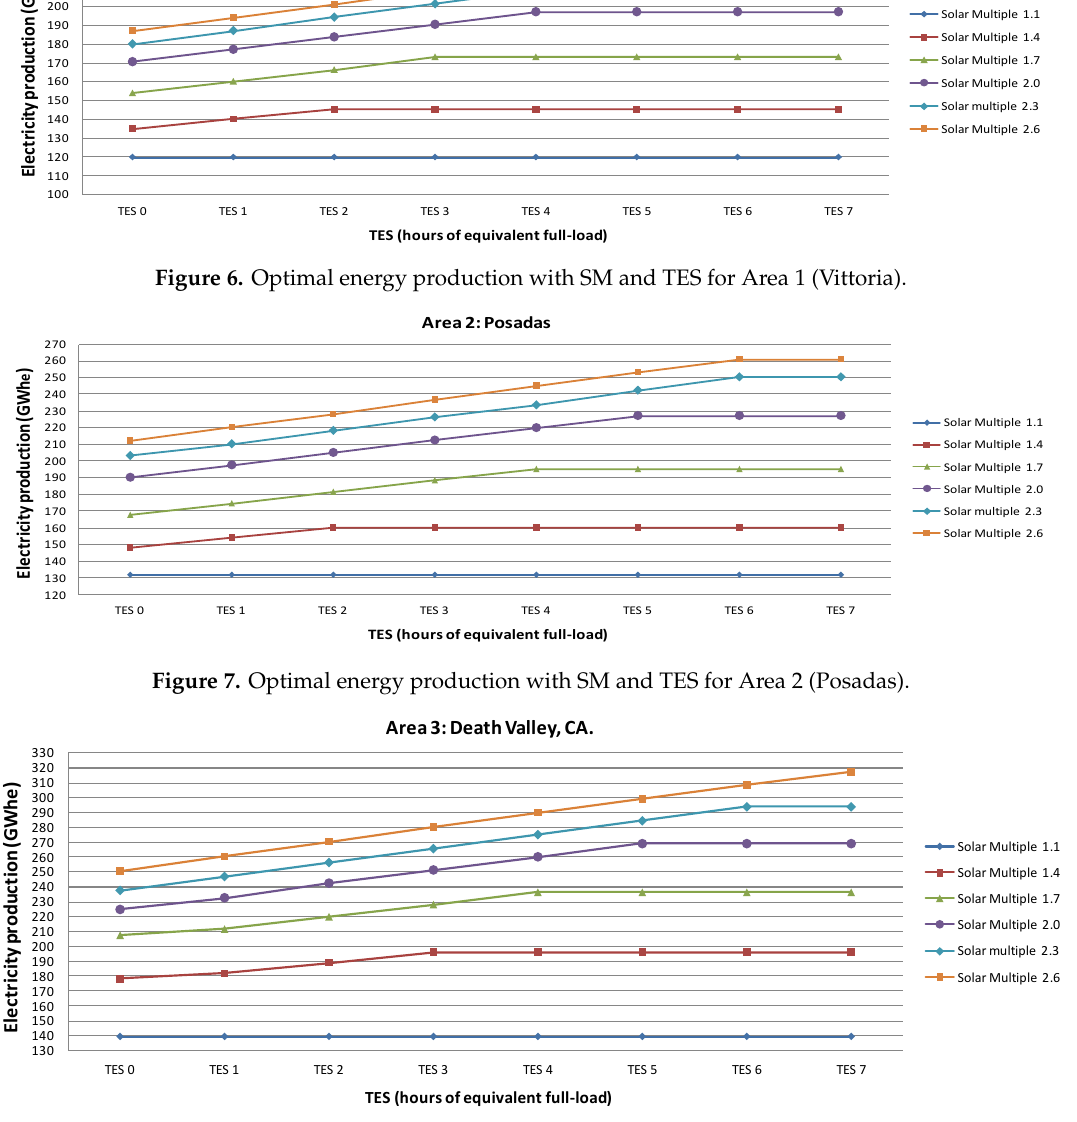
Figure 8. Optimal energy production with SM and TES for Area 3 (Death Valley, CA). Figure 6 indicates the optimal sizing for a solar-thermal plant in this area, with an SM of 2.6 and an equivalent thermal storage of 5 h. More storage does not imply greater total annual production.